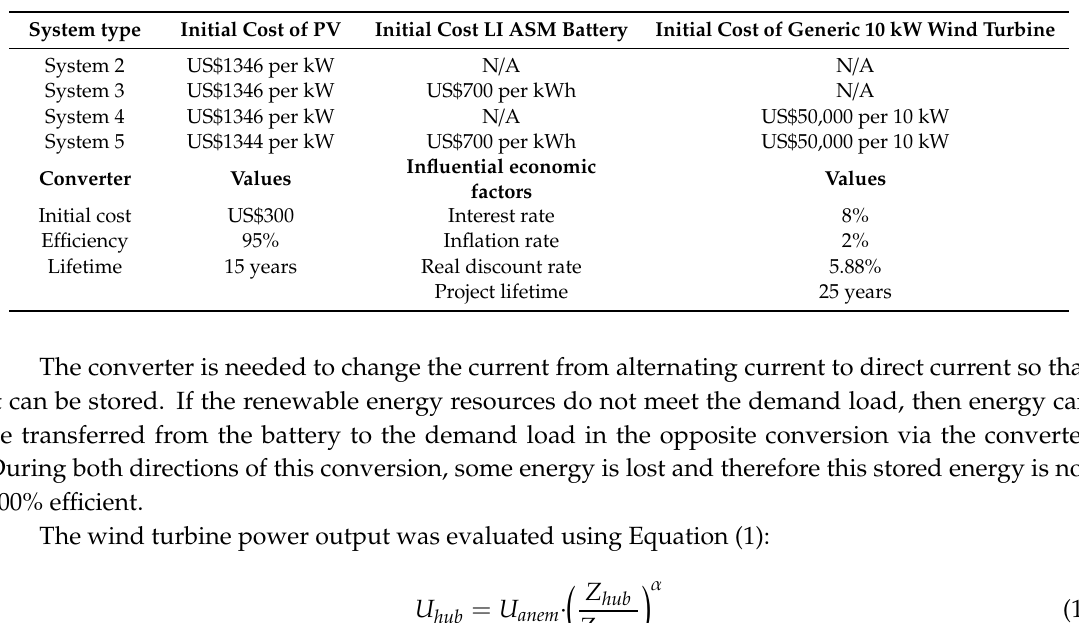
Table 2. Operational and maintenance costs of